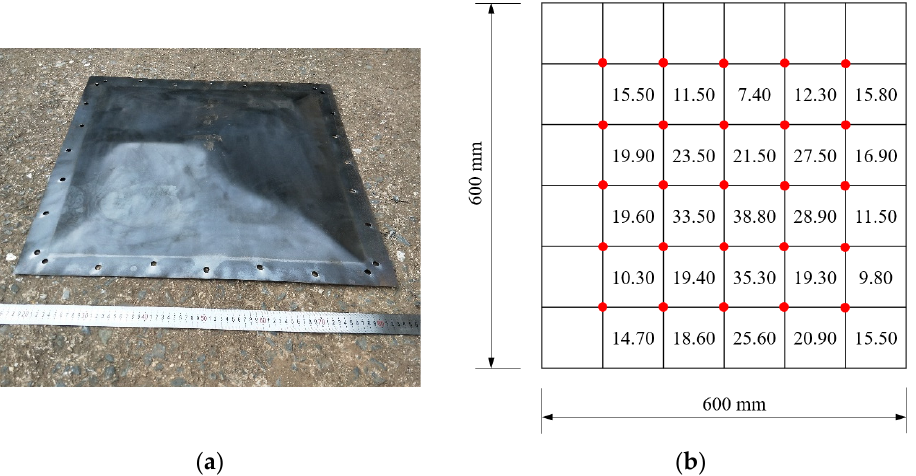
Figure 9. Deformation of the specimen with 5 g TNT. ( a ) Specimen after explosion. ( b ) Deformation details.